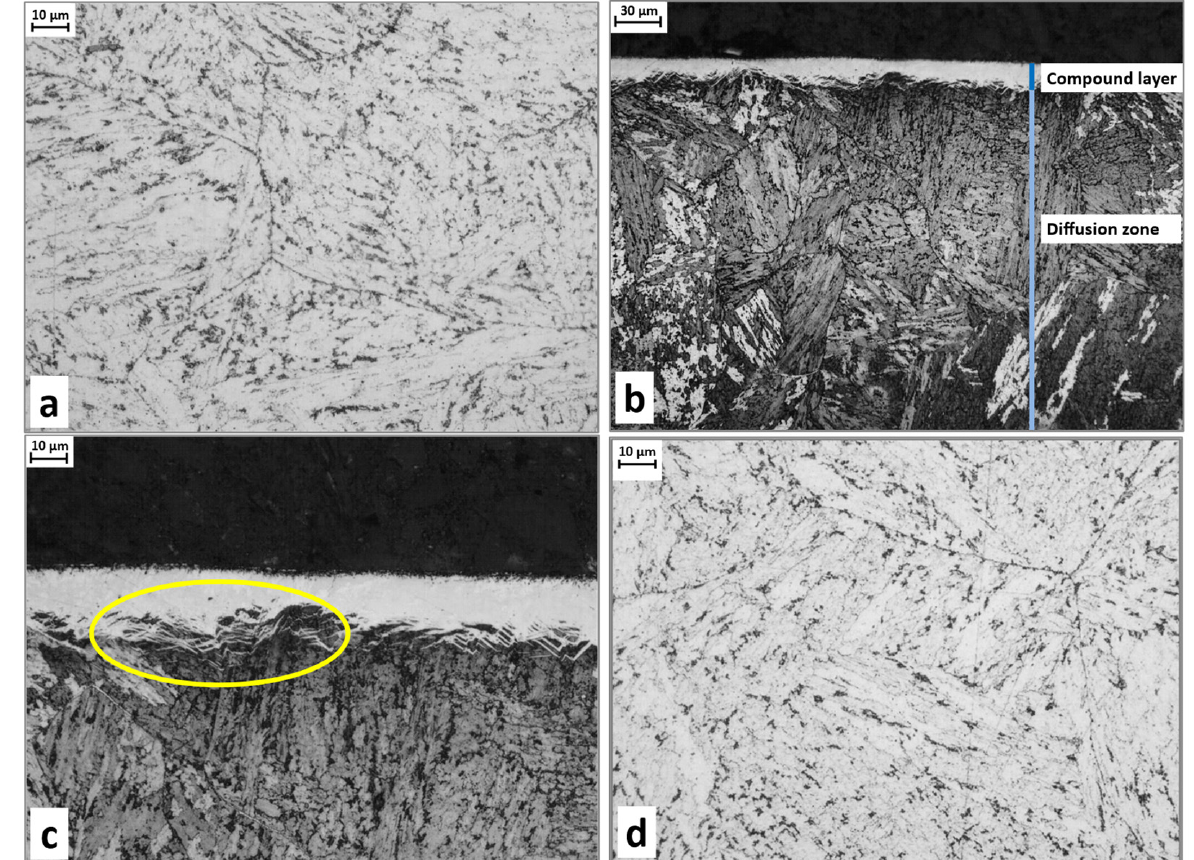
Figure 4. Microstructure analysis: ( a ) core microstructure example of nitrided and untreated specimen 500 × ; ( b ) compound layer and diffusion zone 200 × ; ( c ) compound layer detail with nitriding lamellae generated 500 × after Nital 2% etching; ( d ) core microstructure of the untreated material specimen 500 × after Nital 2% etching.